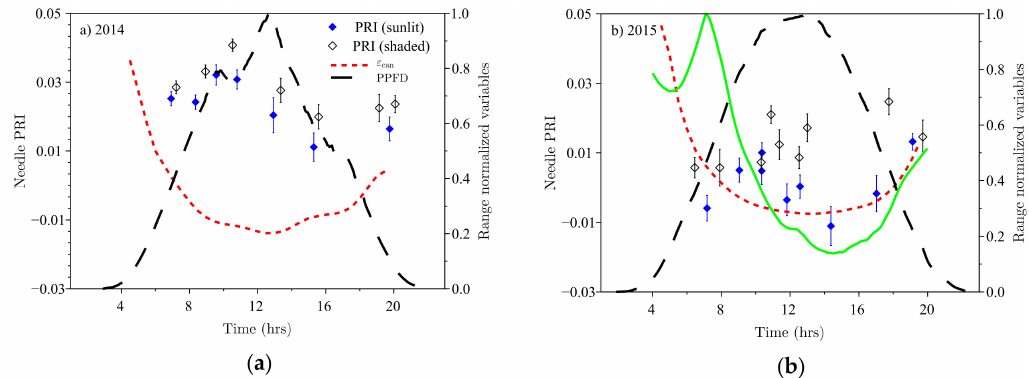
Figure 4. Diurnal variation in needle PRI (symbols, left axes) together with top-of canopy PPFD (dashed line) and the range-normalized canopy light use efficiency ε can (dotted line, right axes): ( a ) 2014; and ( b ) 2015. For 2015 ( b ), canopy PRI data were also available (solid green line).